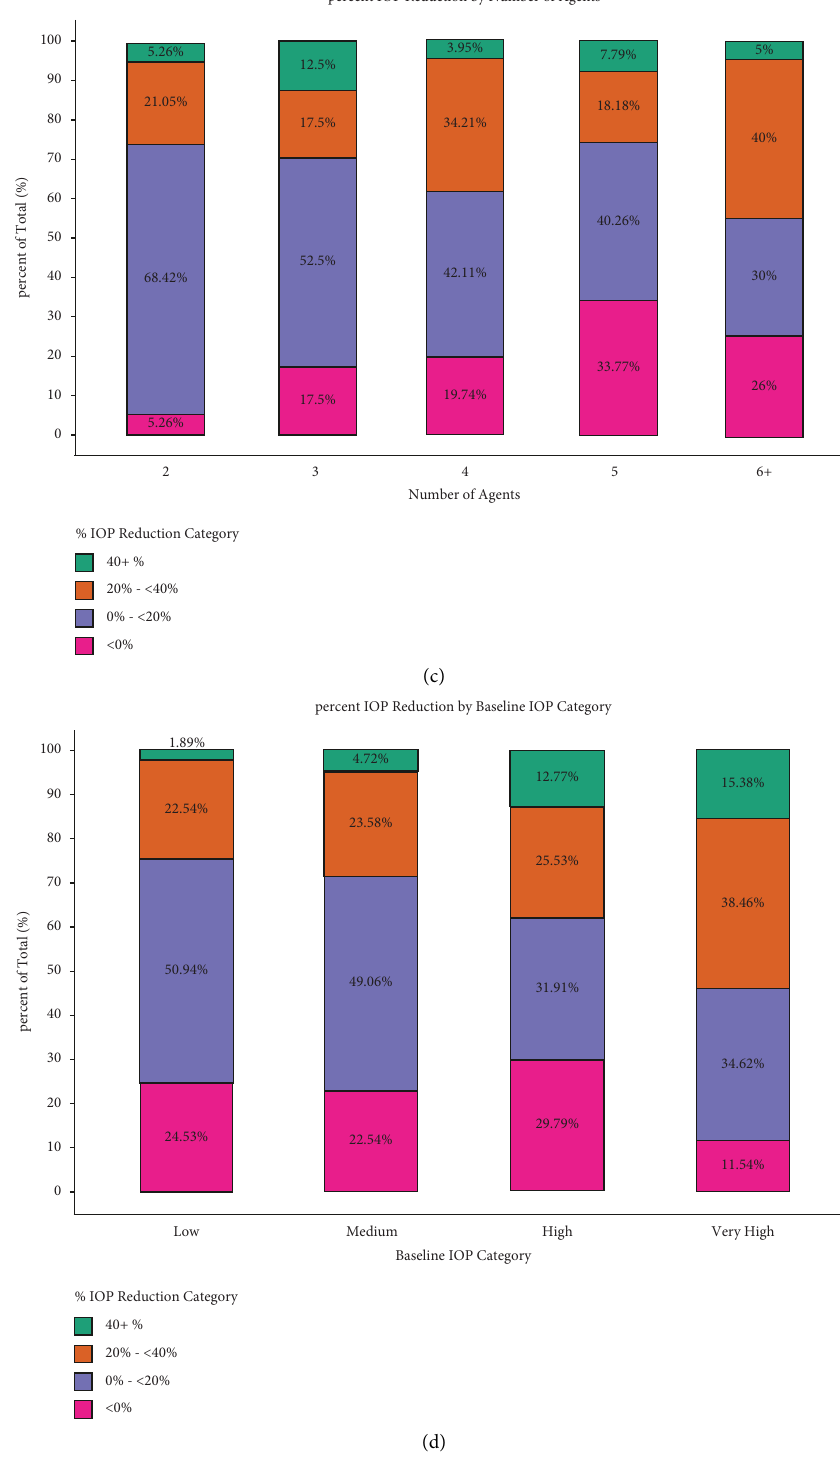
Figure 3: Stacked bar charts for percent IOP reduction from baseline across all patients, number of agents, baseline IOP category, and by the responder type. (a) Percent IOP reduction across all patients. (b) Percent IOP reduction by the number of agents. (c) Percent IOP reduction by the baseline IOP category. (d) Percent IOP reduction by the responder